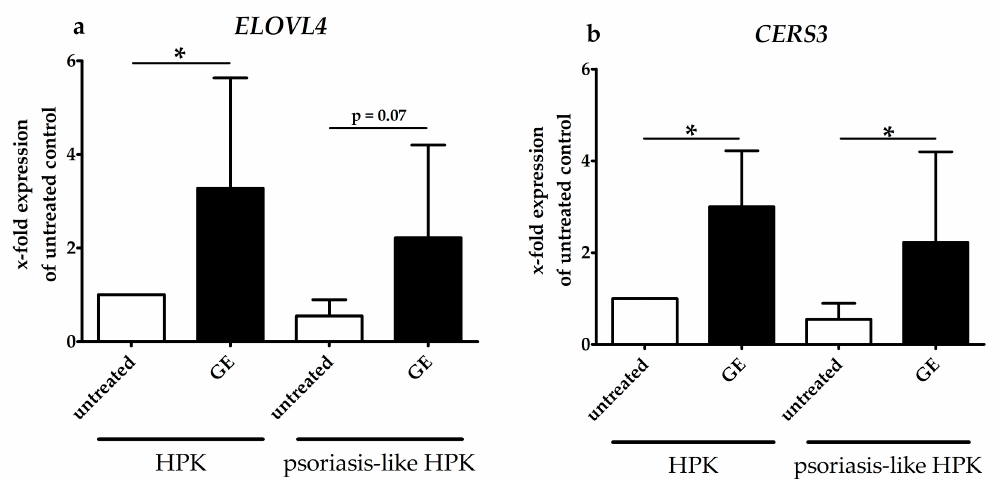
Figure4. Expressionof ELOVL4 and CERS3 inHPKsandpsoriasis-likeHPKs. ( a )HPKsandpsoriasis-like Figure 4. Expression of ELOVL4 and CERS3 in HPKs and psoriasis-like HPKs. ( a ) HPKs and HPKs were incubated with GE (200 µ g / mL) for 24 h. Total RNA was extracted and qPCR was performed psoriasis-like HPKs were incubated with GE (200 µg/mL) for 24 h. Total RNA was extracted and to determine the ELOVL4 gene expression level. To generate psoriasis-like HPKs, HPKs were incubated qPCR was performed to determine the ELOVL4 gene expression level. To generate psoriasis-like with GE (200 µ g / mL) and after 2 h, stimulated with IL-17, IL-22, TNF-and IFN- γ (20 ng each) for 24 h. HPKs, HPKs were incubated with GE (200 µg/mL) and after 2 h, stimulated with IL-17, IL-22, ( b ) HPKs and psoriasis-like HPKs were incubated with GE (200 µ g / mL) for 24 h. Total RNA was extracted TNF-and IFN- γ (20 ng each) for 24 h. ( b ) HPKs and psoriasis-like HPKs were incubated with GE (200 and qPCR was performed to determine the CERS3 gene expression level. Gene expression in relation to the control was calculated using the comparative C T method from Schmittgen and Livak (see materials and methods). Data are presented as mean ± SD, n = 3, * p ≤